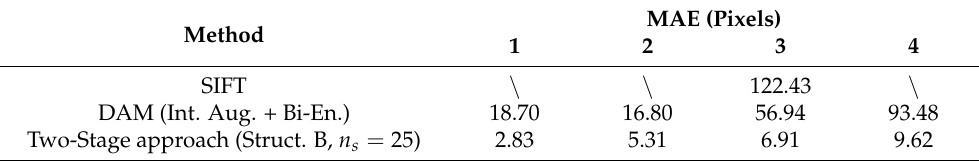
Table 9. Comparison of quantitative results. Columns 1~4 represent the errors of registration for pair 1–4 in Figure 14 respectively. “ \ ” represents the failure of registration. MAE: Mean absolute